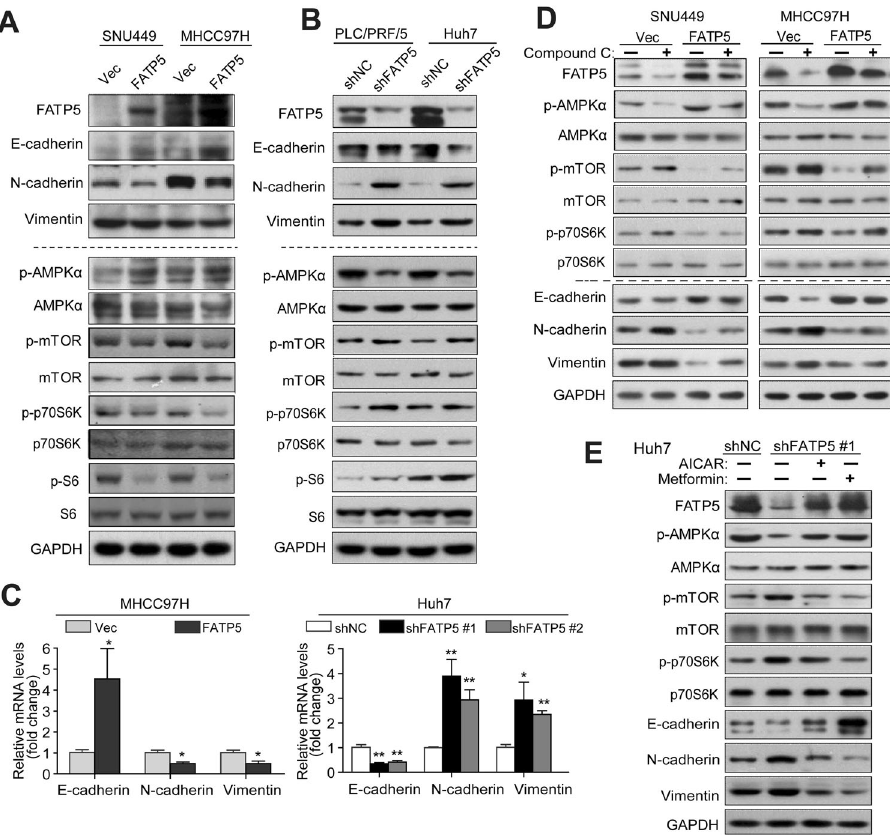
Fig. 3 FATP5 inhibits epithelial-to-mesenchymal (EMT) by regulating AMPK-mTOR-S6K signaling. A , B Expression of EMT markers (E- cadherin, N-cadherin, and vimentin) and phosphorylation status of AMPK α , mTOR, S6K, and S6 in FATP5-overexpressing cells (SNU449 and MHCC97H transfecting Vec or FATP5) or FATP5 knockdown HCC cells (PLC/PRF/5 and Huh7 cells expressing shNC or shFATP5 #1) were analyzed by western blotting. C The mRNA levels of E-cadherin, N-cadherin, and vimentin in indicated HCC cells transfected with empty vector or FATP5, or infected with LV-shNC or LV-shFATP5 (sequence #1 and #2) were evaluated by qRT-PCR. All mRNA values was normalized to β -actin ( Δ Ct) and compared with that in their corresponding control cells ( ΔΔ Ct). The fold change was calculated and presented as 2 − △△ Ct , and the expression levels in MHCC97H-Vec or Huh7-shNC was set as 1. * P < 0.05 and ** P < 0.01 (two-tailed t -test). D , E SNU449 and MHCC97H-Vec and FATP5 cells were treated with or without Compound C (10 μ M) for 48 h ( D ). Huh7-shNC and shFATP5 #1 cells were treated with or without AICAR (1.5 mM) or metformin (5 mM) for 48 h ( E ). Expression of EMT markers and phosphorylation status of AMPK-mTOR-S6K signaling were analyzed by western blotting. For all experiments in ( A , B , D , E ), GAPDH was used as internal loading control. Abbreviations: p-,